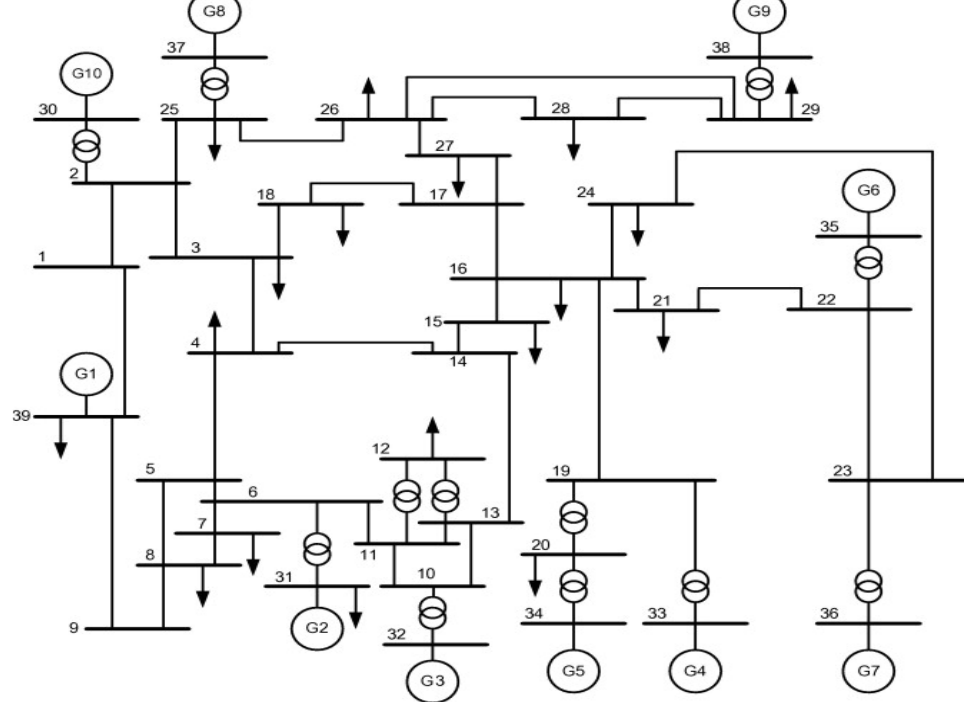
Figure 7. Single ‐ line diagram of 39 ‐ bus New England system. Figure 7. Single-line diagram of 39-bus New England